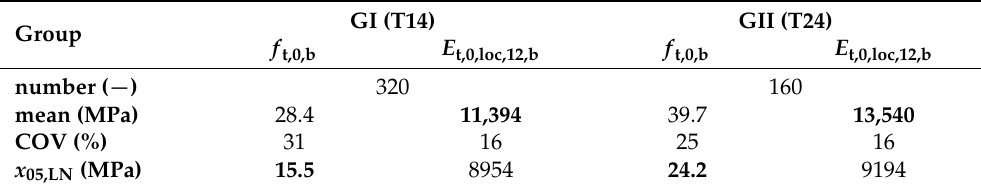
Table 1. Mechanical properties of groups GI and GII; results taken from Schickhofer and Augustin [18] and Kastner et al. [17].